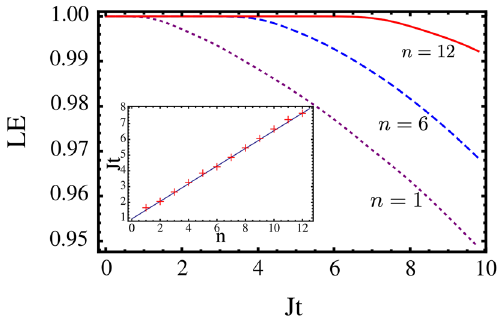
Fig. 6 The decay of the four-loop LE at various n , where n labels the site on which the second perturbation P 2 is applied. The first perturba- tion P 1 is always applied to the first site. Inset: The time at which the LE starts to decay as a function of n , the distance between the two sites. Red crosses are numerical data. Solid line is the best liner fit. Note that the slop of the linear curve is the inverse of the butterfly velocity (in the unit of J )